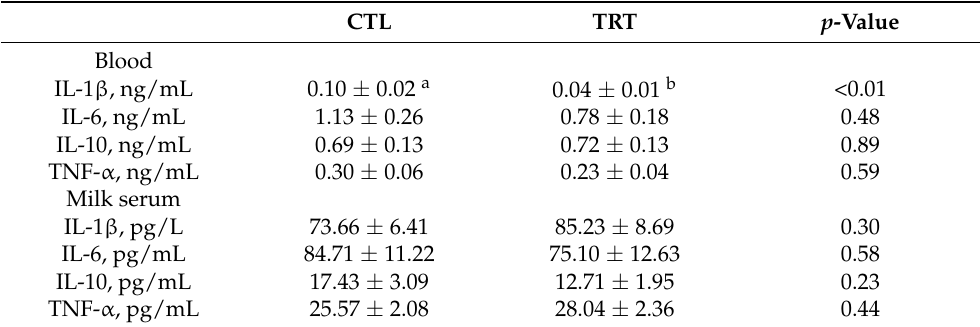
Table 2. Effects of dietary silymarin supplementation during late gestation and lactation on the cytokines in blood and milk serum of lactating sows. CTL TRT p -Value Blood IL-1 β , ng/mL 0.10 ± 0.02